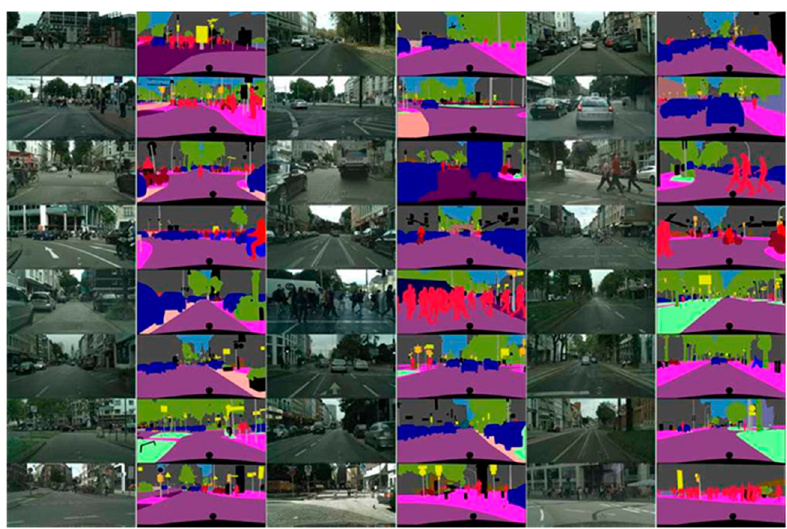
Figure 17. Results from the proposed method for the Cityscapes database photos. Table 2. Frame rate result for the proposed method with the Cityscapes database images.